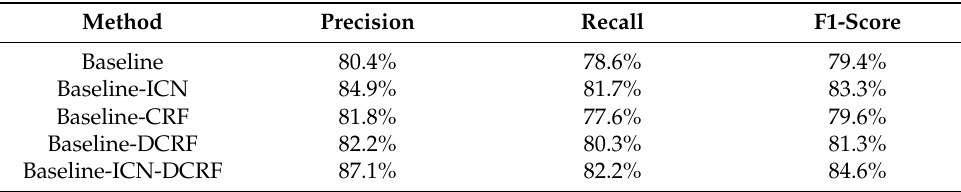
Table 3. Results of the ablation study on the Massachusetts roads